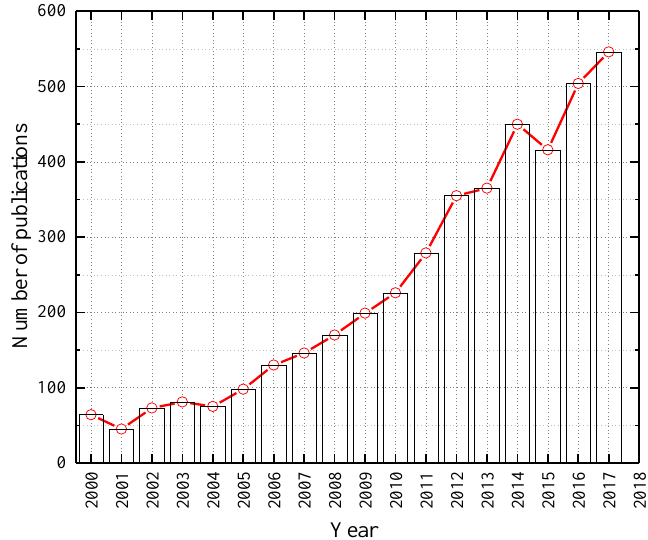
Figure 1. Number of publications per year indexed in Web of Science matching keywords of “concrete and limestone” in search of “Topic”.